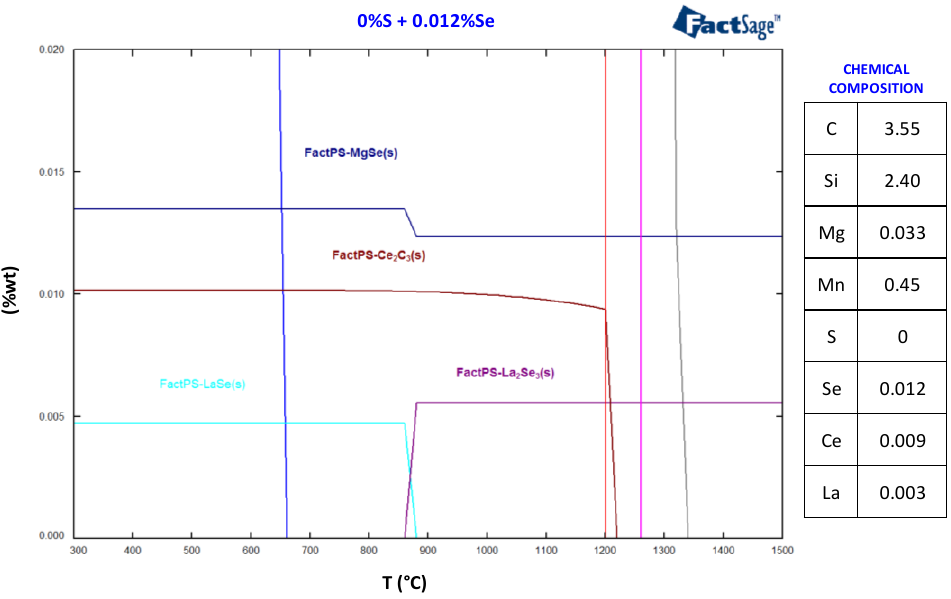
Figure 3. Stability of selenides according to FactSage, between 300 and 1500 °C, assuming the initial chemical composition listed in the figure.